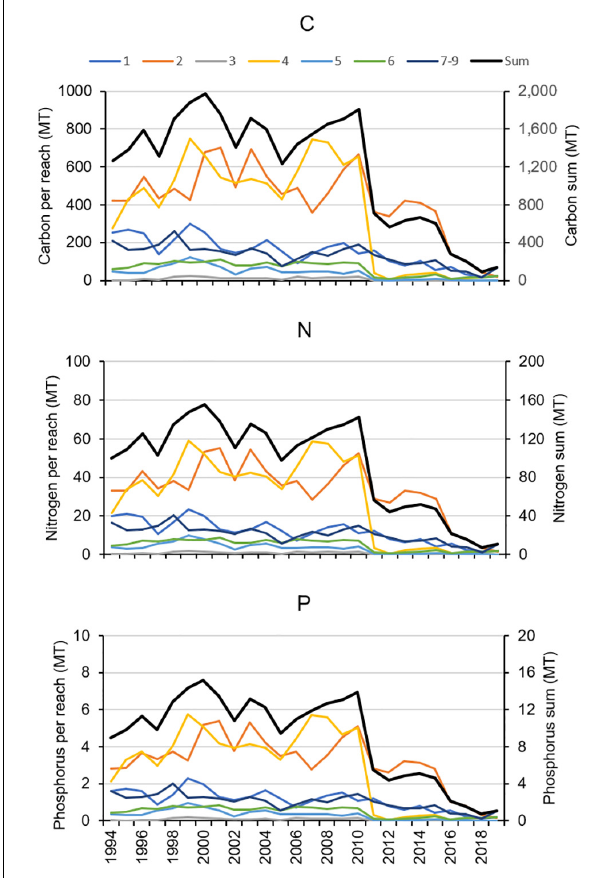
FIGURE 13 | Changes in the amount of carbon (C), nitrogen (N), and phosphorus (P) stored in seagrass in each reach and in the whole